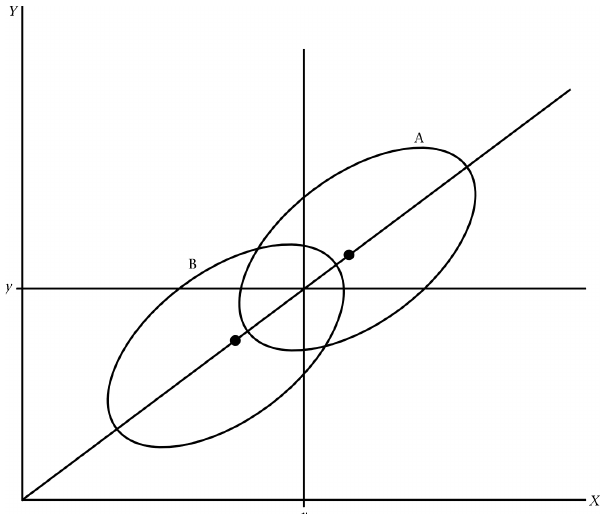
Figure 1: No predictive bias is present